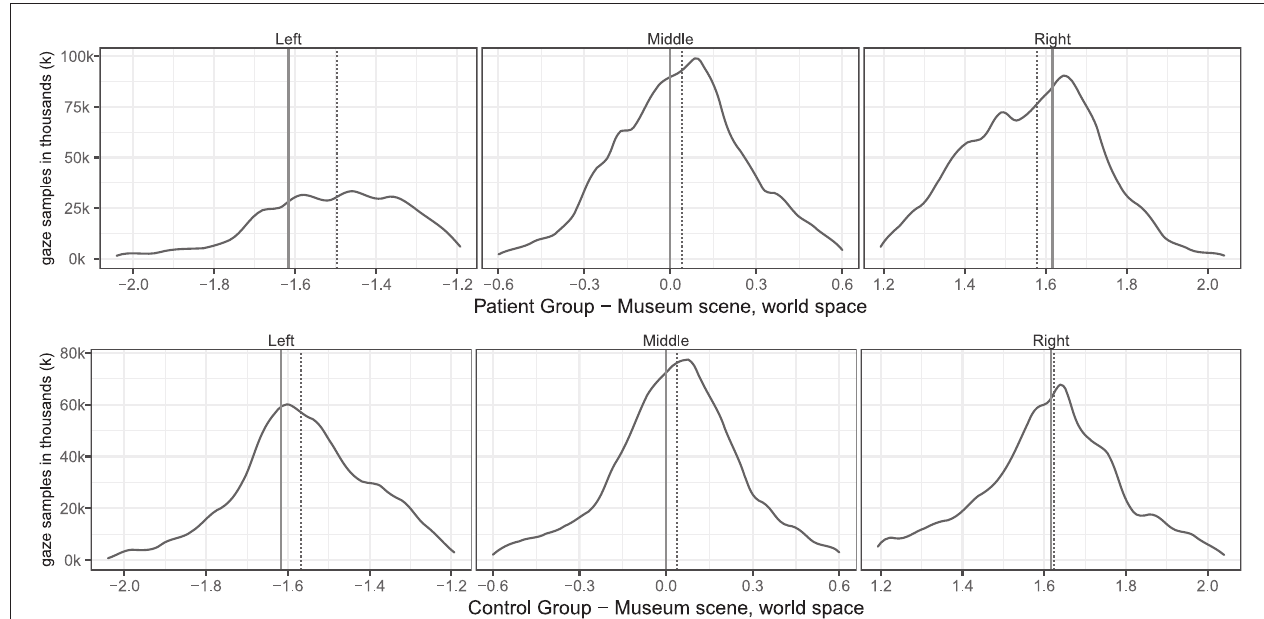
FIGURE 2 | Group level spatial distribution of gaze samples on the (solid line) and median gaze (dotted line) of patients and controls. The x -axis spans the horizontal world space of the virtual museum scene from − 2.0 to 2.0. The y -axis plots the corresponding gaze sample counts in thousands (k).